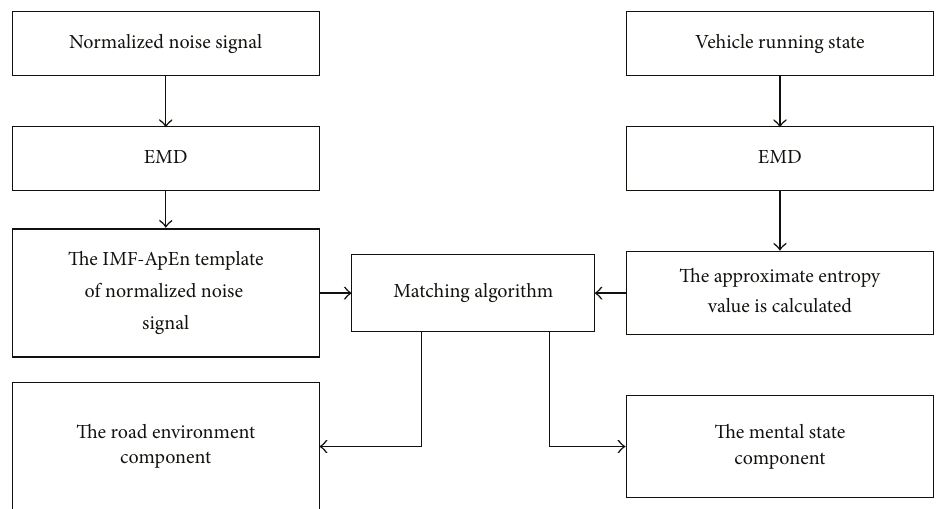
Figure 1: The basic process of removing the component of road